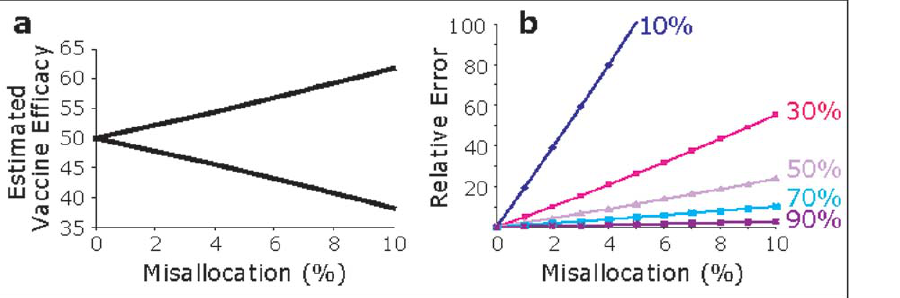
Figure 3. Influence of CCL3L1-CCR5 GRG status on vaccine efficacy. ( a ) Estimated vaccine efficacy as a function of the percentage of subjects that are misallocated (m) with respect to their CCL3L1-CCR5 genotype across the placebo or vaccine trial arms. The model is for a preventive vaccine that has a true efficacy of 50%. The upper line in this plot depicts estimated vaccine efficacy as a function of misallocation of subjects with a low GRG towards the vaccine arm, resulting in a fallacious increase in the estimated vaccine efficacy. The lower line depicts the converse situation, i.e., misallocation of subjects with a low GRG towards the placebo arm, resulting in a fallacious decrease in the estimated vaccine efficacy. ( b ) Plots depict the difference (relative error) between the true and estimated vaccine efficacy as a percentage of the true vaccine efficacy for varying values of m. Methods are described in SOM , section 2 .